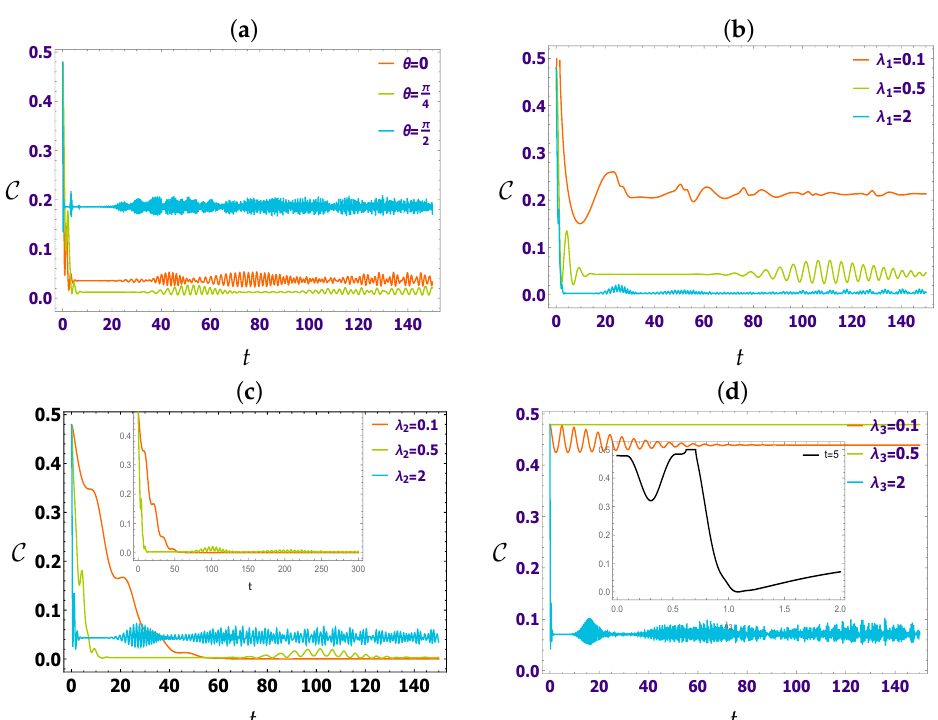
Figure 4. The behaviour of qubit non-classicality through skew information C , where ζ = 3 = Ξ . ( a ) λ 1 = 1 = λ 2 = λ 3 ; ( b ) θ = π /4, λ 2 = 1 = λ 3 ; ( c ) θ = π /4, λ 1 = 1 = λ 3 ; ( d ) θ = π /4, λ 1 = 1 = λ 2